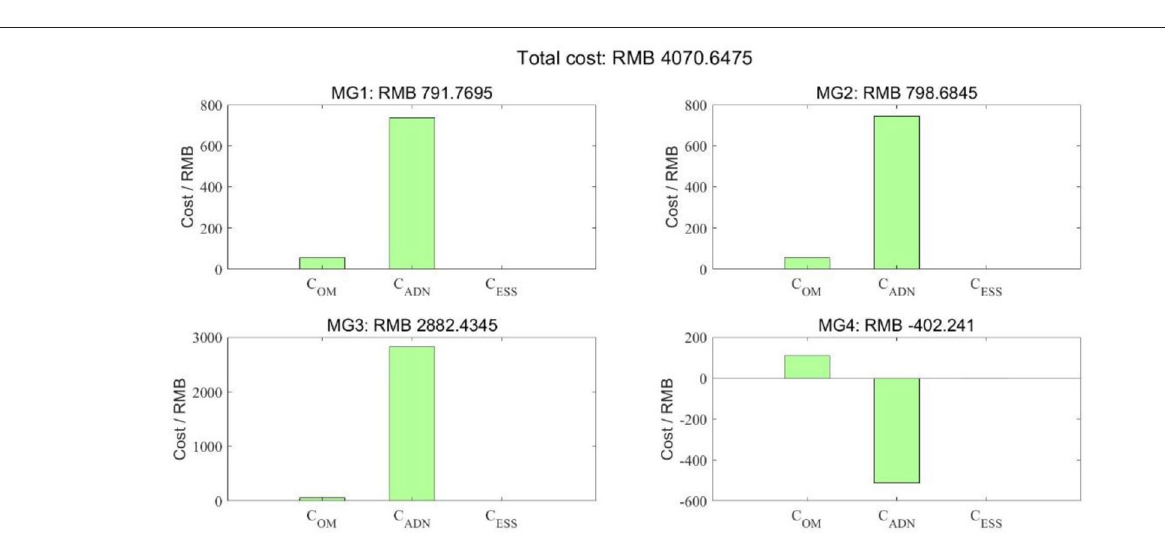
Frontiers in Energy Research |